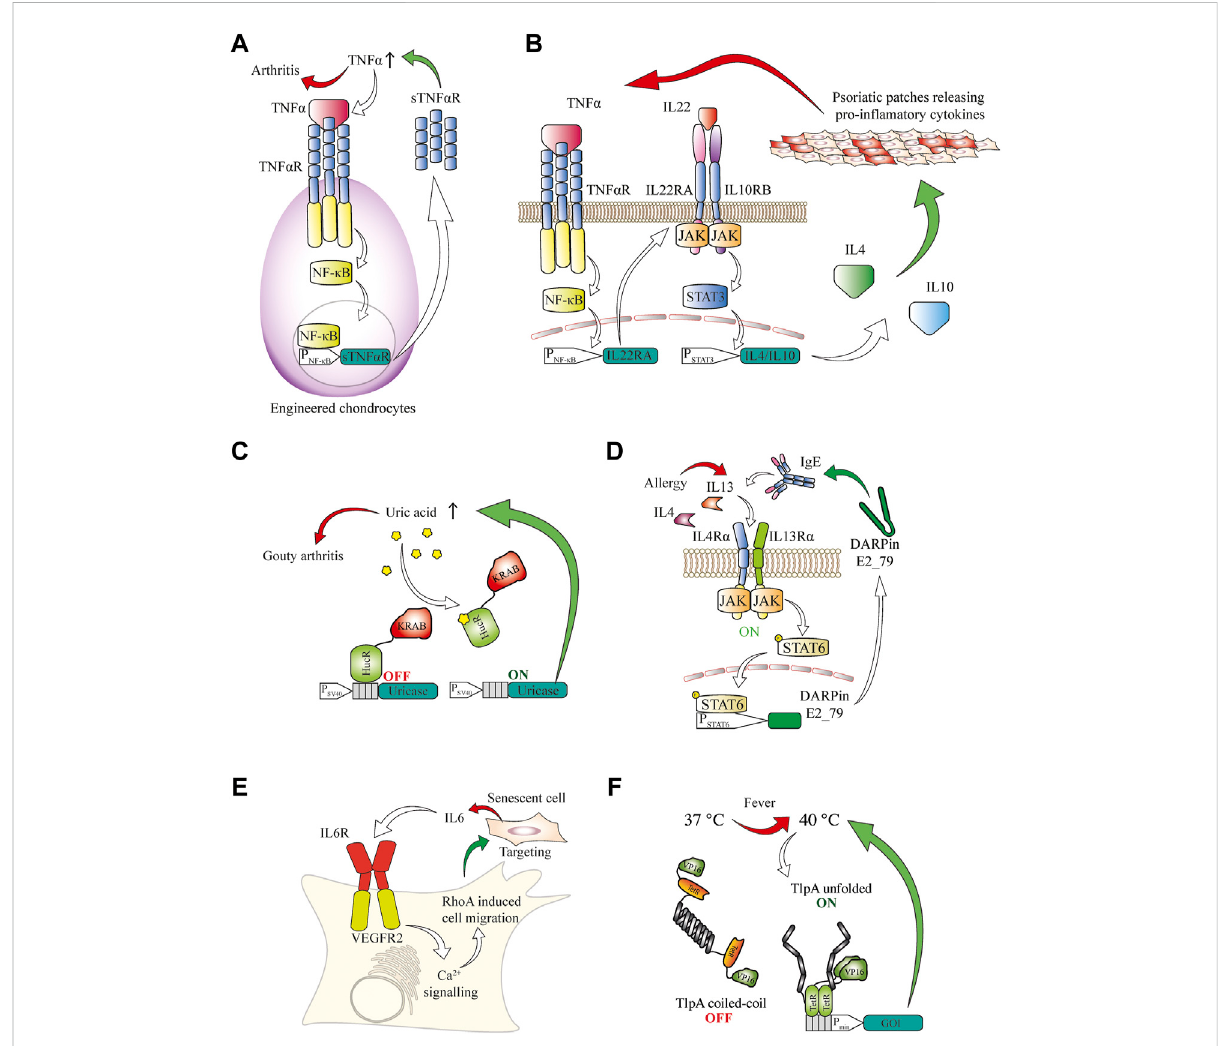
FIGURE 3 (A) Engineered chondrocytes generate an anti-in fl ammatory response in arthritis. Localized joint in fl ammation and the release of TNF α are among the main drivers for the development of arthritis. Chondrocytes are engineered to express TNF α R, and its signaling is routed via the NF- κ B pathway to a chimeric promoter that induces expression of an inactive soluble TNF α R. This competes with active TNF α R for TNF α binding, thereby counteracting the in fl ammation in a closed control loop. (B) AND gate logic-based closed-loop cellular treatment for psoriatic skin patches based on the TNF α and IL22 cytokines. Increased TNF α concentration in the blood induces the expression of the IL22RA receptor subunit in engineered cells.This enables thesensing ofIL22,which,togetherwithTNF α ,isasignaturecytokineinpsoriasis.Uponactivation ofthisreceptorthe induced STAT3 signaling is rerouted to a chimeric STAT3 promoter for the expression of the anti-in fl ammatory cytokines IL4 and IL10, which suppress psoriatic fl ares. (C) Closed-loop cellular therapeutic circuit to counteract increased blood concentration of urate associated with gout. A fusion protein of the HucR urate-sensitive repressor from D. radiodurans with the KRAB inhibitory domain is bound to the HucR operator after an SV40 promoter and represses transcription under normal conditions. In the presence of inducing urate concentrations, the repressor is released from the DNA and A. fl avus urate oxidase is produced and secreted, effectively reducing the urate concentration, which leads to repression of the promoter. (D) Closed-loop anti-allergic response by engineered mammalian cells. The presence of allergy-associated cytokines such as IL4 and IL13 can be sensed through the type II IL4R, which in turn activates the STAT6 signal transduction cascade. A minimal promoter operated by STAT6inducesexpressionofIgEtargetingDARPinE2_79topreventfurtherdegranulationofimmunecellsandescalationoftheallergicresponse. (E) Targeting of senescence phenotypes. Sensing of senescence-associated cytokines such as IL6 is enabled in engineered cells expressing a fusion receptor consisting of the IL6 extracellular domain and the VEGFR2 intracellular signaling domain. Upon activation, the receptor triggers calcium signaling and enables cellular migration towards the senescent cells through a modi fi ed calcium-sensitive RhoA for cytoskeletal remodeling. (F) A